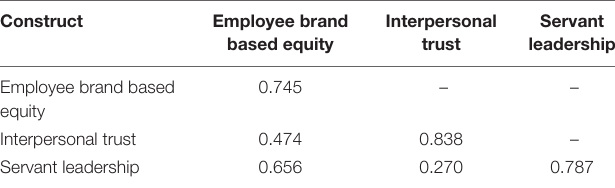
TABLE 2 | Discriminant validity [Fornell and Larcker (1981)